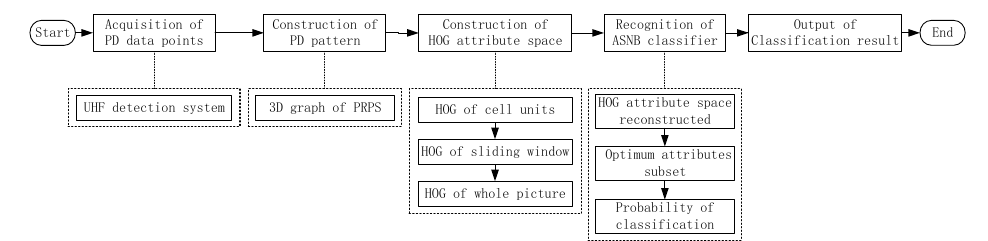
Figure 2. Entire flow chart of presented method.